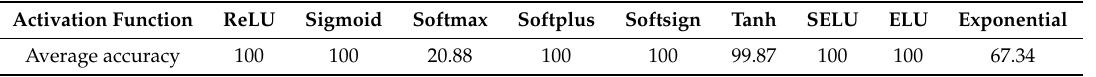
Table 8. Performance comparison of DNN according to the activation functions.